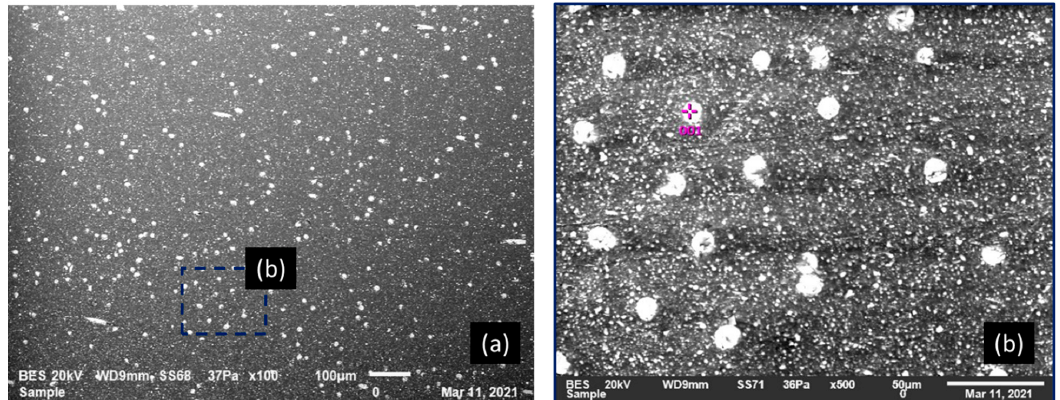
Figure 9. SEM micrographs of the transverse surface of a fractured tensile test sample with 5% GF/PBT composite, 20 kV, 9 mm working distance, 36 Pa: ( a ) BES macro-image; ( b ) fiber distribution on PBT matrix.